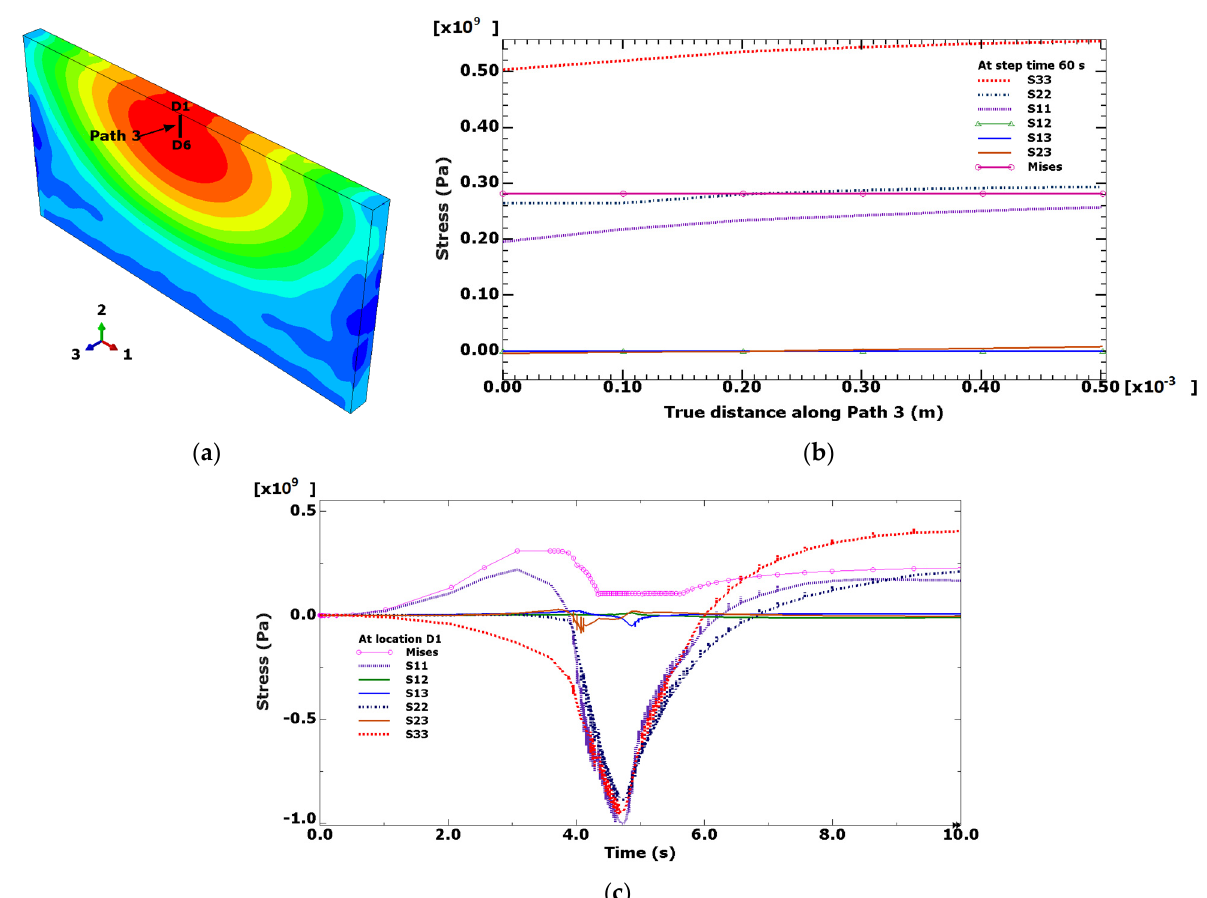
Figure 9. ( a ) Description of Path 3, ( b ) stress vs. true distance along Path 3 at step time 60 s, and ( c ) stress evolution at location D1.